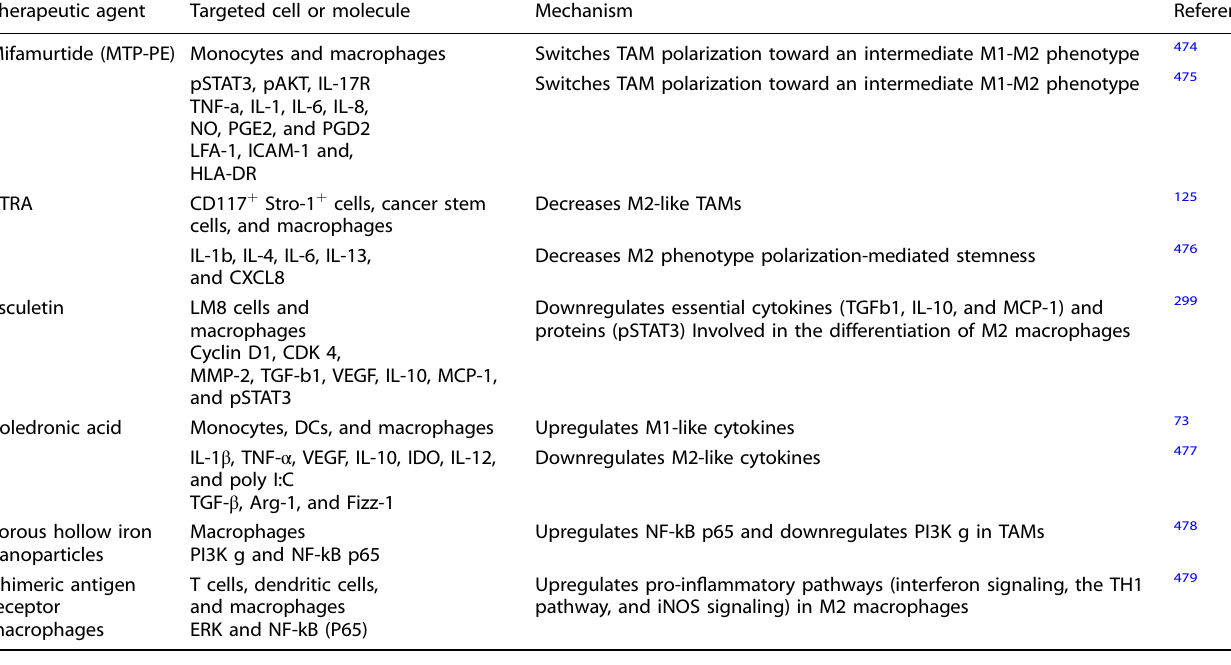
Table 1. Therapeutic TAM-modulating agents for osteosarcoma Therapeutic agent